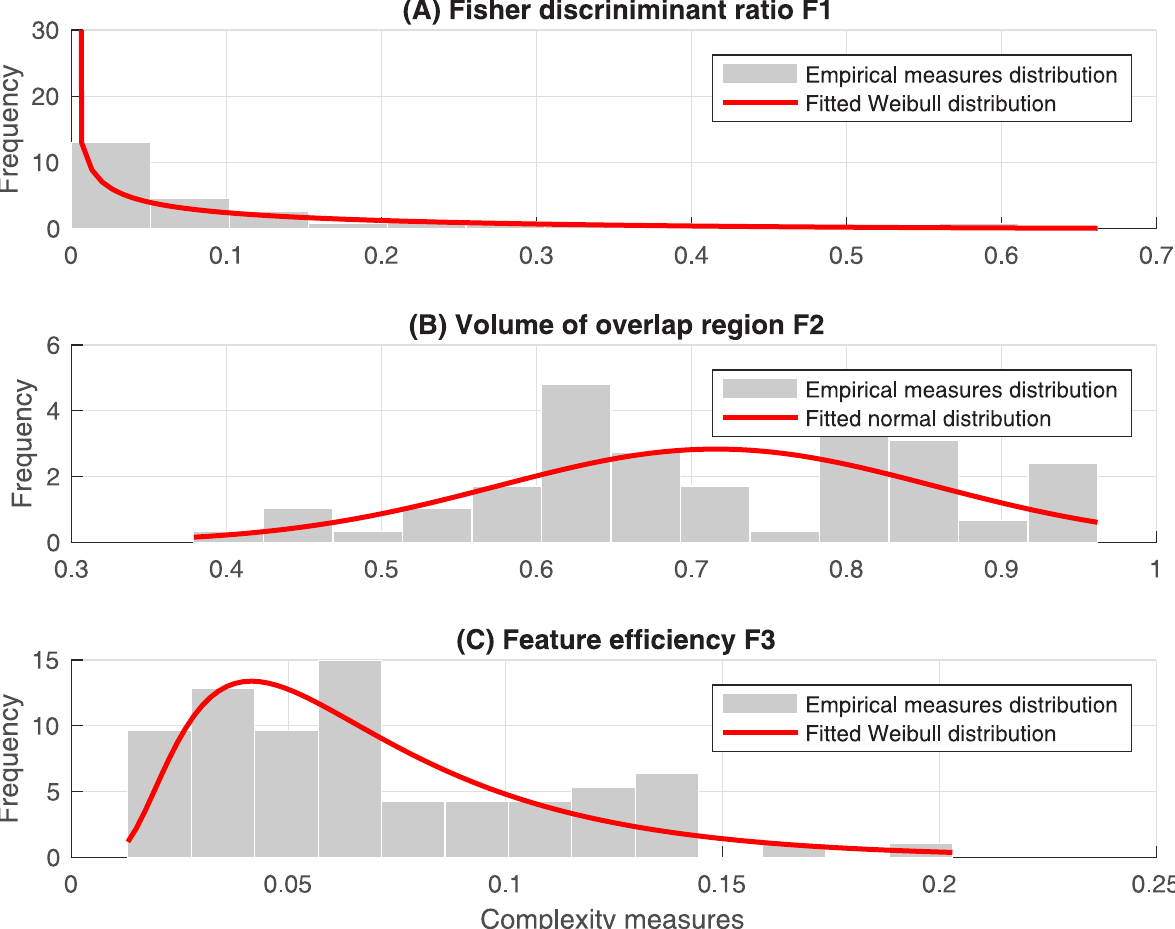
Fig 2. Empirical distribution of the class ambiguity measures (A) The Fisher discriminant Ratio F1, (B) The ratio of the width of the overlap interval F2 and (C) The individual feature efficiency F3. The red curves are the corresponding fitted distribution function.